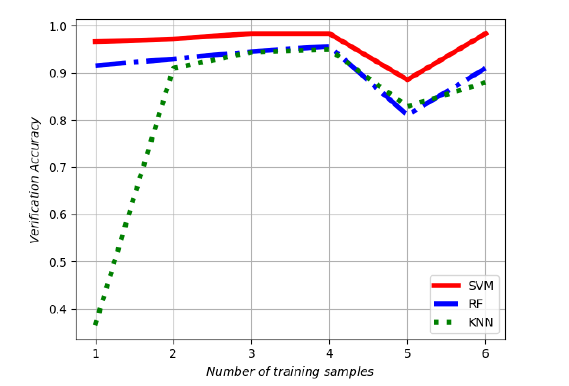
Figure 14. Accuracy curves of SVM, RF, and KNN classifiers in the 2D contact-free HKPU database.